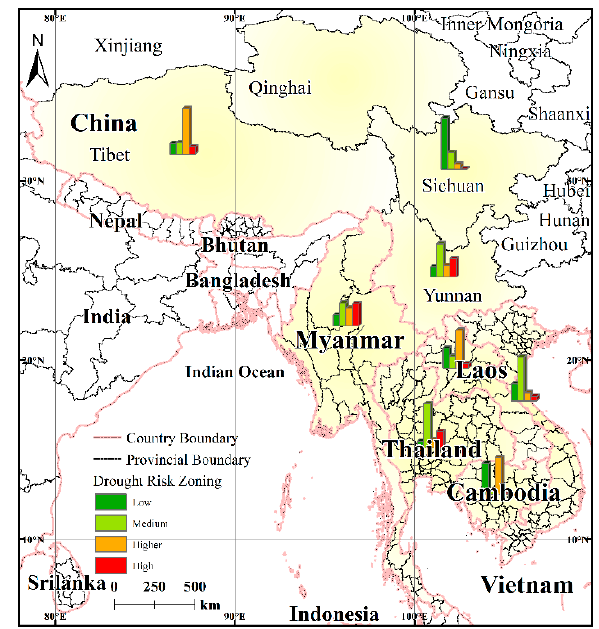
Figure 13. Regional differences in the agricultural drought risk in the LMR.